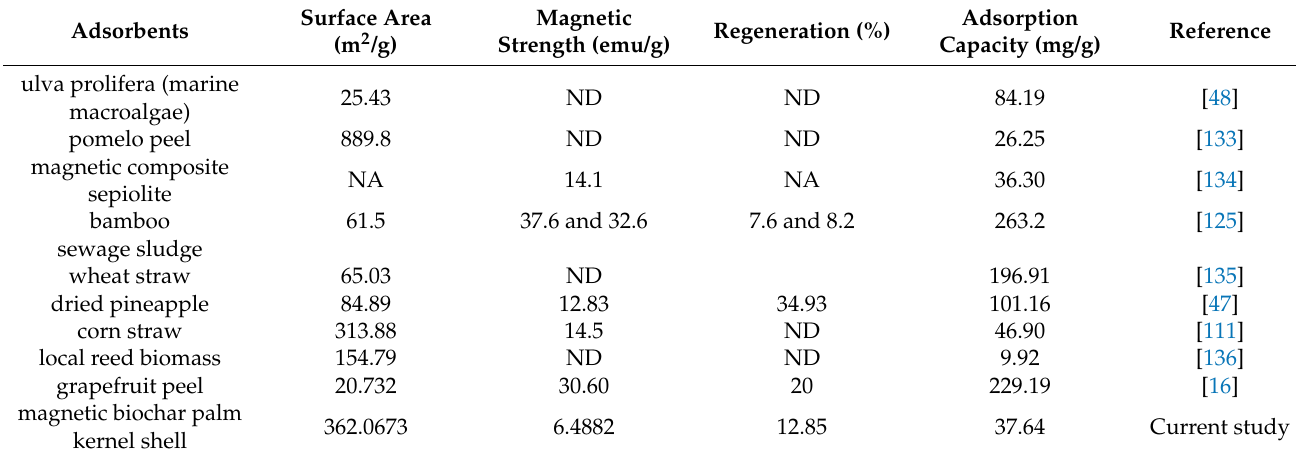
Figure 16. Regeneration of magnetic biochar for BPA removal. Experimental conditions: m = 0.5 g; [BPA] = 20 ppm; and temperature (293.15 K). Table 7. Comparison of specific surface area, magnetic strength, and adsorption capacity of BPA on different adsorbents from previous literature with current